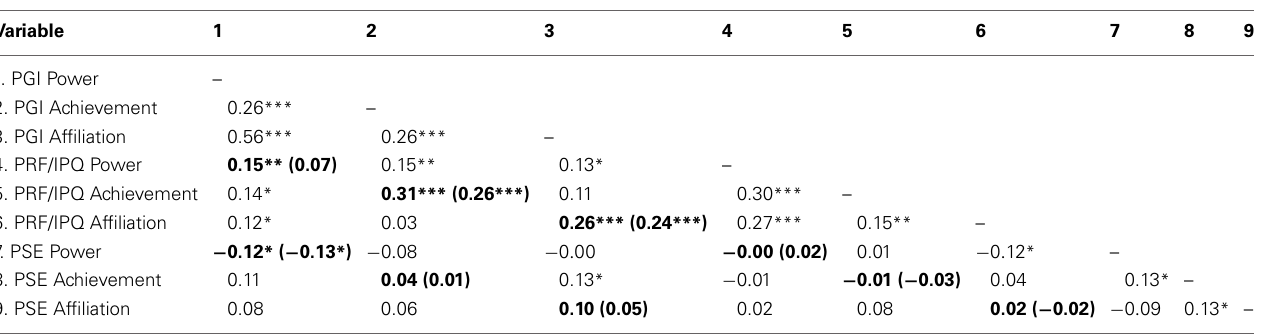
Table 2 | Correlations between personal goal commitments (PGI), self-attributed motives (PRF/IPQ), and implicit motives (PSE).